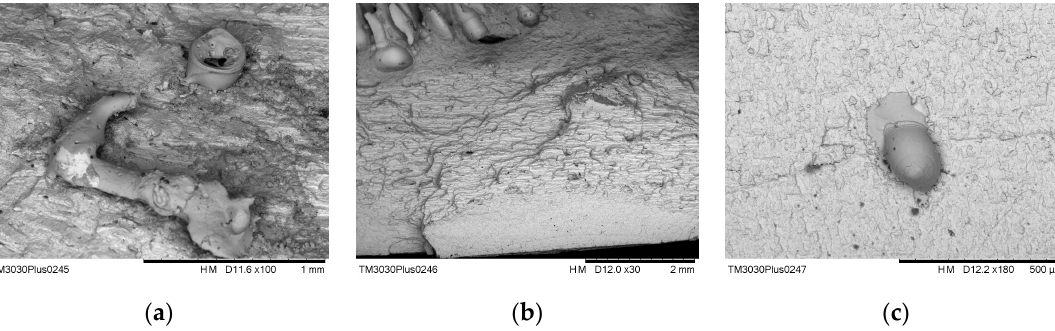
Figure 13. SEM of defects in the fracture zone of the specimen 766-FM2: ( a ) inclusions; ( b ) worm holes and ( c ) void in the propagation area.